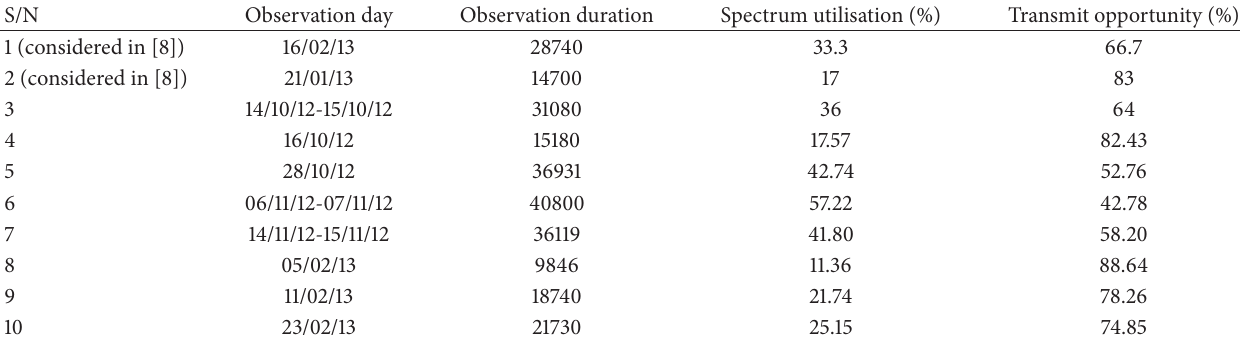
Table 1: Analysis results of the spectrum utilisation and transmit